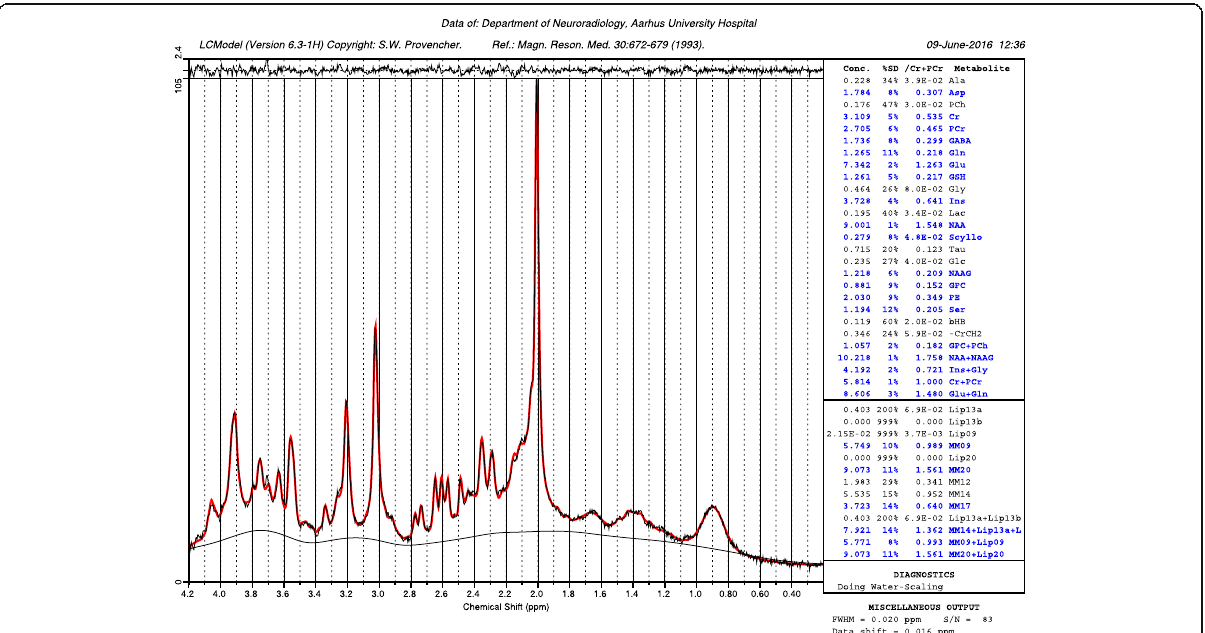
Fig. 3 Top: Example spectrum from a representative migraine patient from the somatosensory voxel position. The red line is the LCModel fit of the data from this patient, the thin black line with the same shape as the red fit is the raw data. The baseline is the thin black line lowest in the spectrum. At the top of the plot is the residuals of the fitted raw data to the model, i.e. the raw data minus the fitted data. Quality data: for this spectrum: S/N 83 and a delta shift of 0.016ppm, FWHM = 0.020 ppm. Bottom: The GABA fit from the same spectra